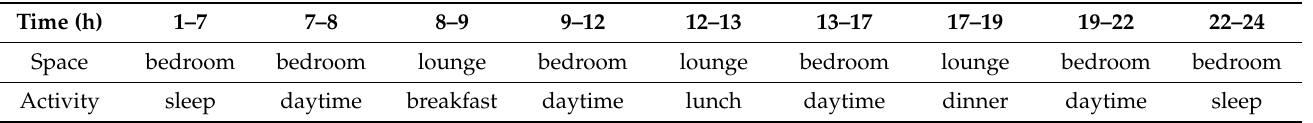
Table 8. Time periods of spaces occupied by the same resident over a 24 h period in